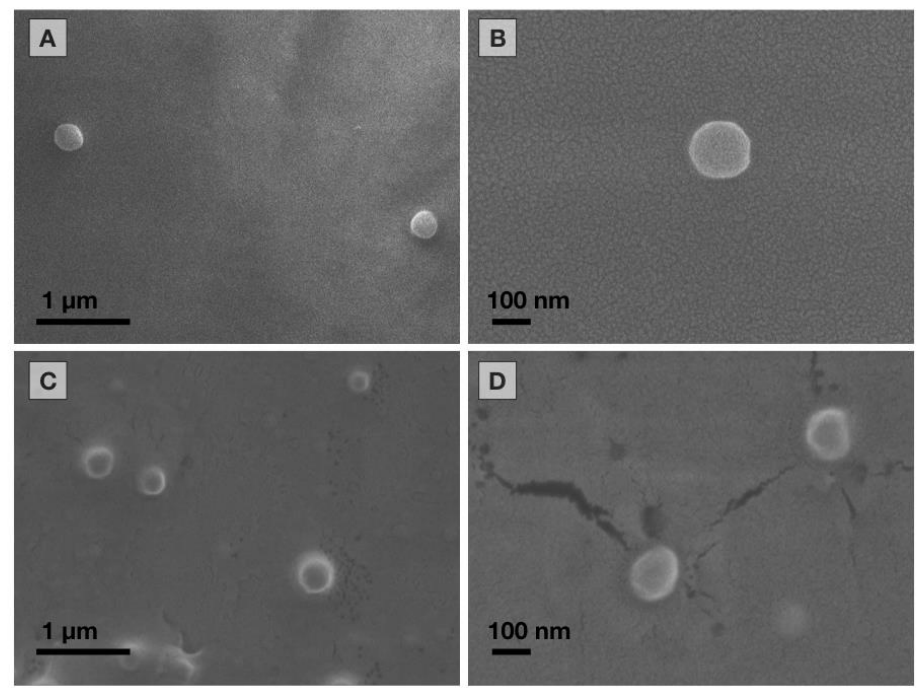
Figure 1. Morphology of nanoparticles by scanning electron microscopy. ( A ) PCL/PVA 25,000×, ( B ) PCL/PVA 100,000×, ( C ) PLGA/PVA nanoparticles (NP) 25,000×, and ( D ) PLGA/PVA NP 100,000×.